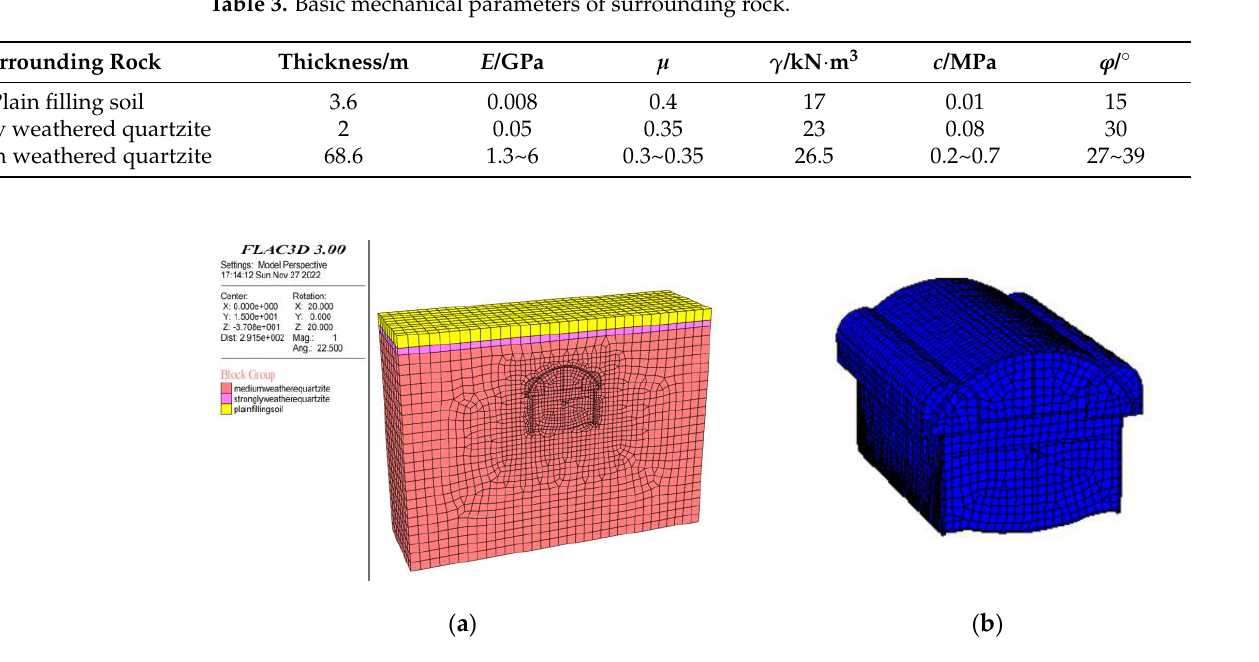
Figure 7. Field monitoring data curve of earth pressure box. Figure 8. Field monitoring data curve of displacement measuring point.